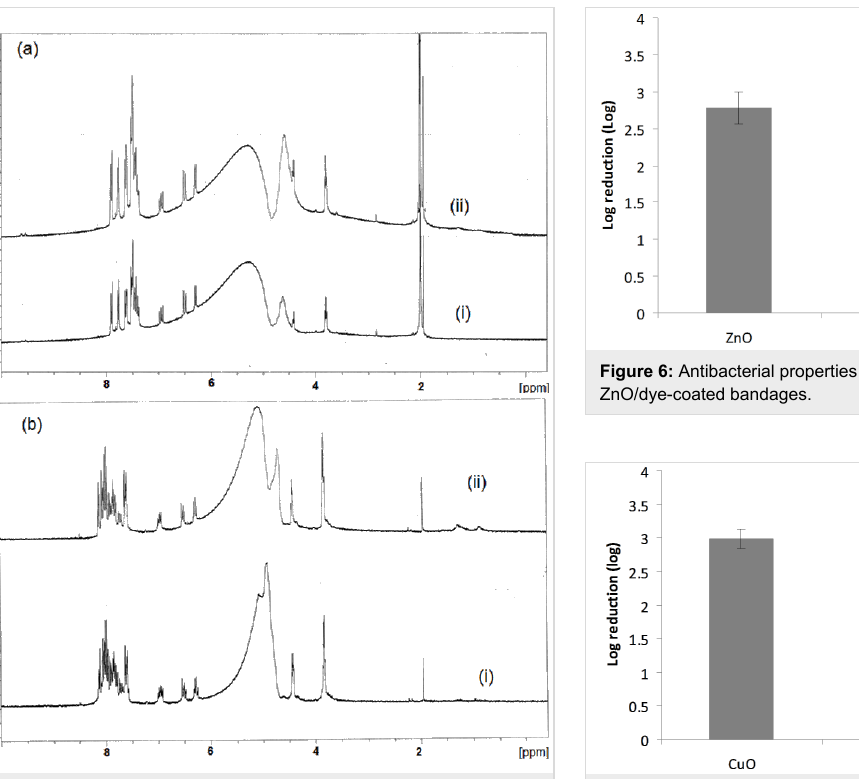
Figure 5: 1 H NMR spectra of the dyes solution of (a) RO16 and (b) RB5 before (i) and after (ii) the sonochemical treatment.